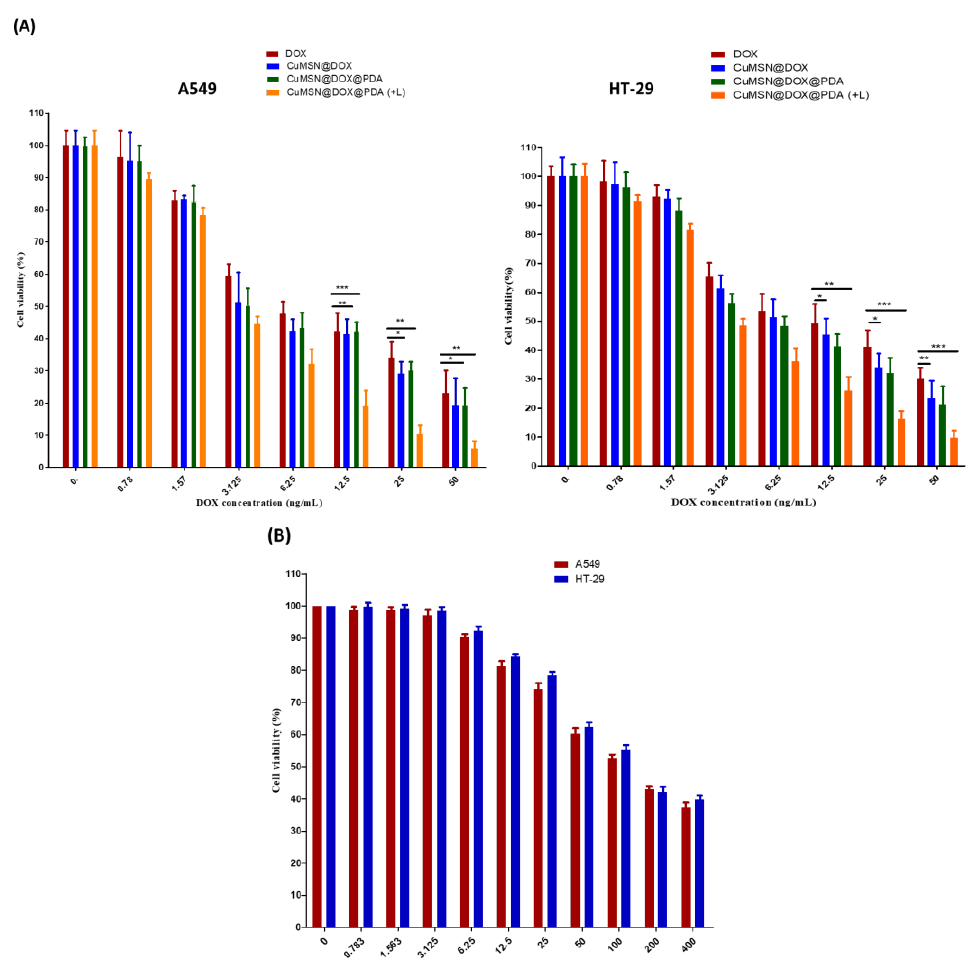
Figure 6. ( A ) In vitro cell-viability studies on the dose-dependent cell viability of A549 and HT-29 cells incubated with CuMSN, DOX, CuMSN@DOX, CuMSN@DOX@PDA, and CuAl-LDH@DOX@PDA (+L) for 24 h, and CuAl-LDH@DOX@PDA (+L)-treated groups were irradiated with a light source for 5 min after 24 h treatment (DOX-equivalent dose). ( B ) Toxicity profile investigations of the A549 and HT-29 cell with CuMSN. ***, **, and * denotes the significant difference between DOX vs CuMSN@DOX and DOX vs CuMSN@DOX@PDA (+L).